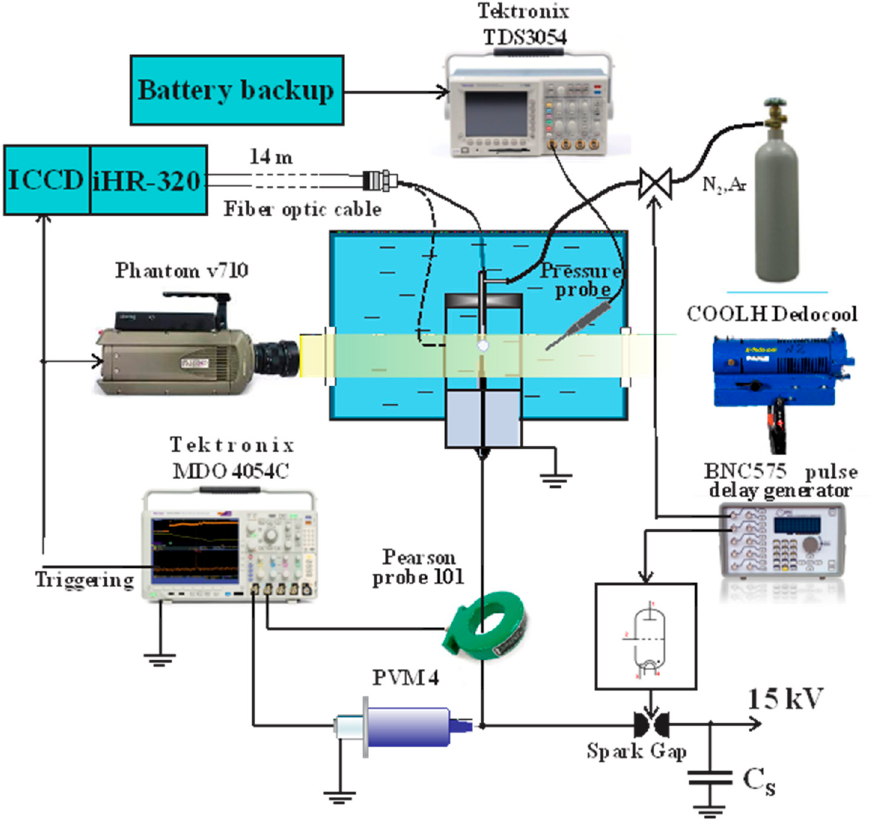
Figure 1. Experimental setup for spectroscopy investigation of spark discharge in water.